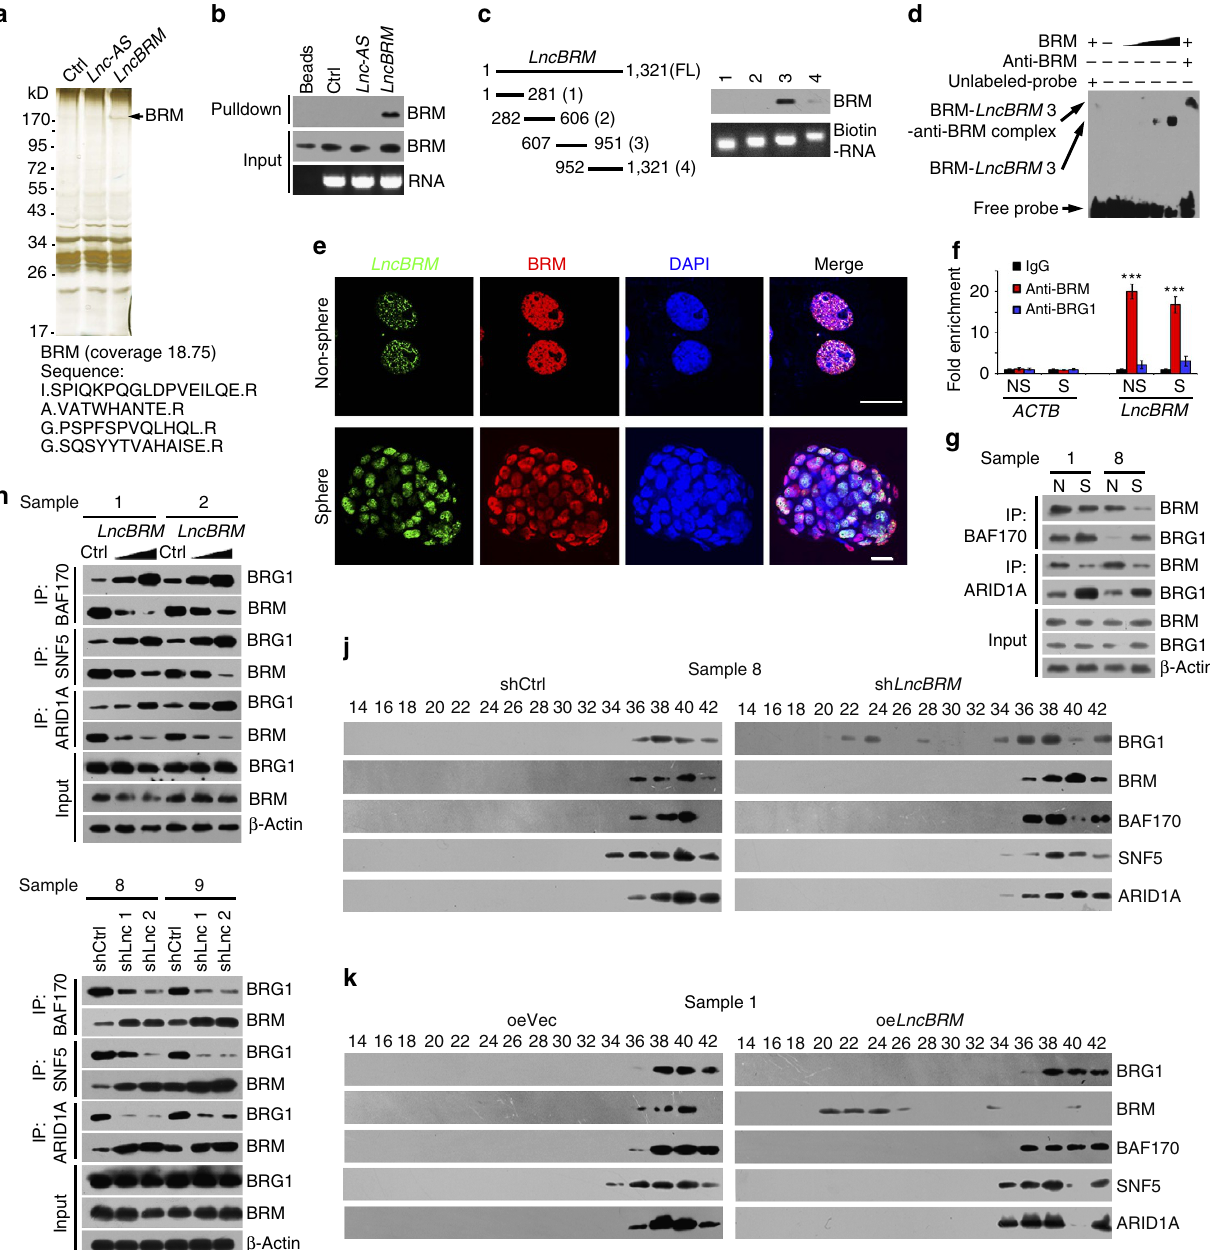
Figure 3 | LncBRM associates with BRM to initiate the BRG1/BRM switch. ( a ) LncBRM intron sequence (Ctrl), lncBRM antisense ( Lnc-AS ) and lncBRM transcripts were labelled with biotin and incubated with oncosphere lysates, followed by silver staining and mass spectrometry. Black arrow denotes BRM. ( b ) RNA pulldown was conducted using lncBRM transcript, followed by immunoblotting. ( c ) Domain mapping of lncBRM transcript. ( d ) LncBRM was incubated with increased doses of BRM, followed by electrophoretic mobility shift assay (EMSA). The 3 segment of lncBRM was labelled with biotin for probing. ( e ) Non-spheres and spheres were visualized by fluorescence in situ hybridization (FISH). Scale bar, 10 m m. ( f ) Antibodies against BRM or BRG1 were used for RNA immunoprecipitation, followed by RT–qPCR. ACTB served as a negative control. ( g ) Spheres (S) and non-sphere cells (N) were lysed and followed by immunoprecipitation with BAF170 and ARID1A antibodies. BRG1 and BRM enrichment was analysed with western blotting. ( h ) Different doses of lncBRM transcripts were incubated with oncosphere lysates and followed by co-immunoprecipitation (co-IP). ( i ) LncBRM -depleted HCC primary spheres were lysed for co-IP as in h . ( j , k ) The indicated oncosphere lysates were fractionated and followed by size fractionation with glycerol gradient ultracentrifugation. Elute gradients were used for western blotting. Data are shown as means ± s.d. Two tailed Student’s t -test was used for statistical analysis, *** P o 0.001. Data represent at least three independent